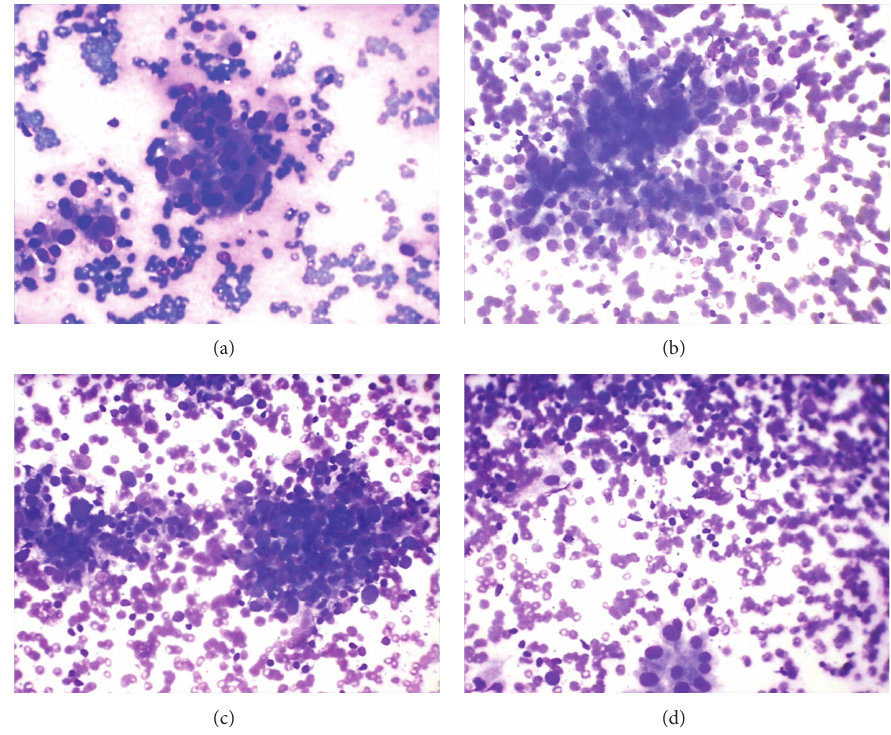
Figure 1: (a) Grade I: cluster of follicular epithelial cells infiltrated by few lymphoid cells (Giemsa × 400). (b) Grade II: cluster of follicular epithelial cells infiltrated by significant lymphoid cells (Giemsa × 400). (c) Grade III: total destruction of follicle with dense infiltration by lymphoid cells (Giemsa × 400). (d) Grade III: lymphoid infiltrate with residual follicular epithelial cells.